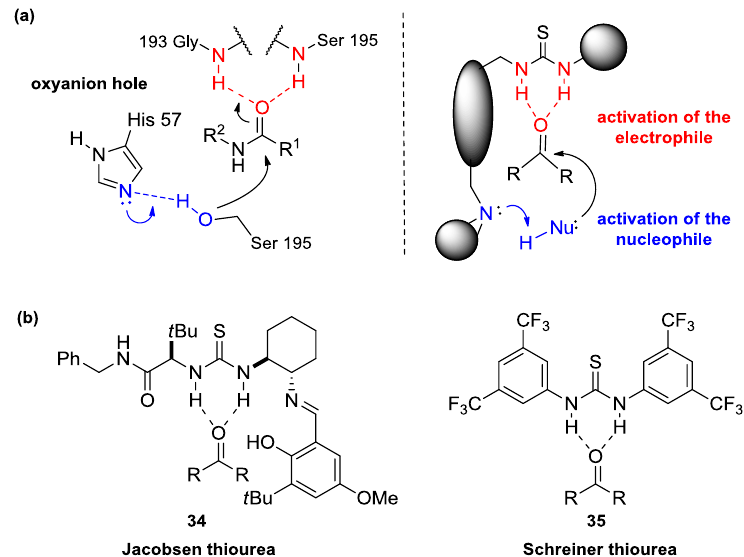
Figure 11. (a) The so-called ‘ oxyanion hole ’ in serine protease activating a carbonyl; (b) hydrogen bonding organocatalysts activating a